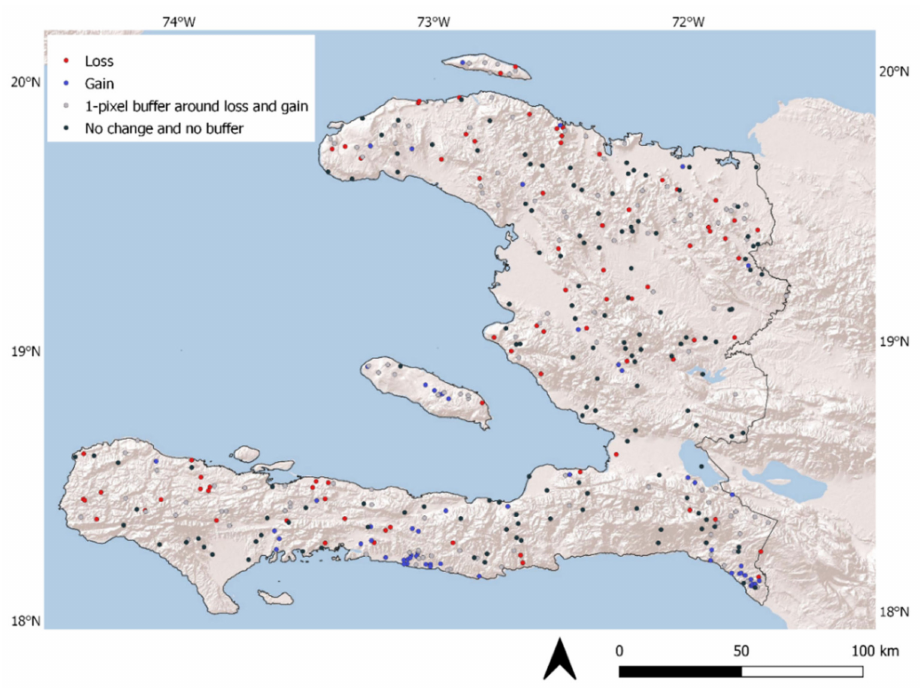
Figure 4. Map showing the location and stratum of pixels sampled from GFCC. The color reflects the stratum from which the pixel was sampled.